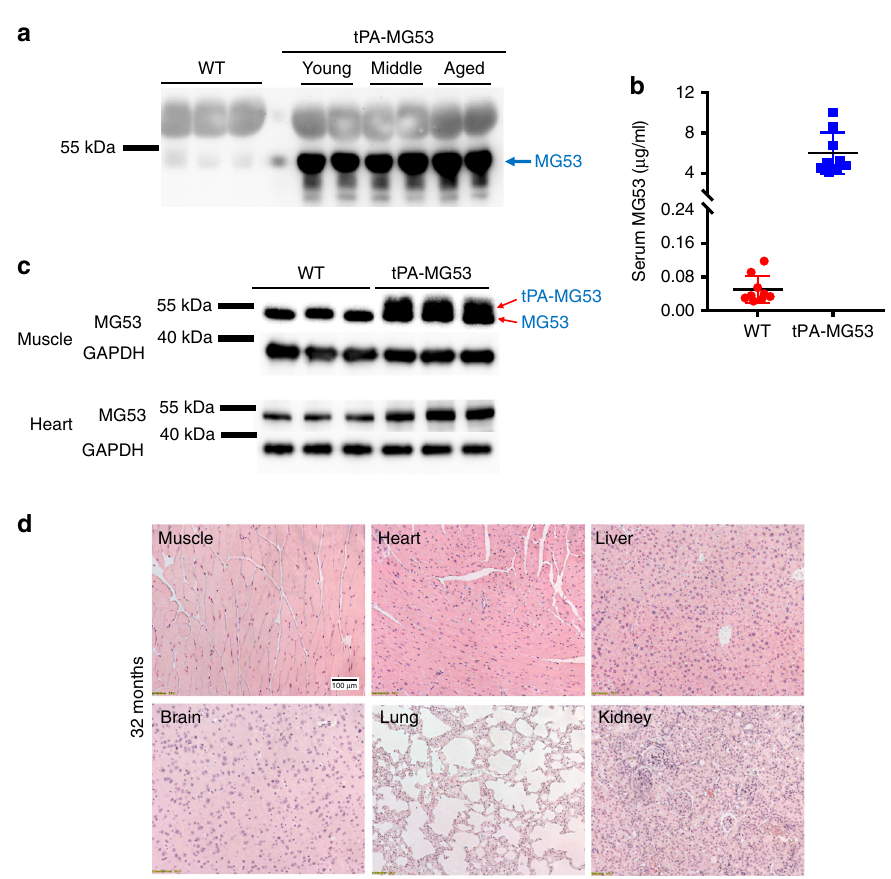
Fig. 1 Mouse model with sustained elevation of MG53 in the bloodstream. a 1 µ l sera derived from 3-month wild type (WT) and tPA-MG53 mice at 2 months (young), 12 months (middle) and 24 months (aged) were probed with anti-MG53 antibody. b Quanti fi cation of serum levels of MG53 in wild type and tPA-MG53 mice by western blot ( n = 10, wild type; n = 9 for tPA-MG53, P < 0.0001). c Skeletal muscle (2 µ g per lane) and heart (2 µ g per lane) derived from tPA-MG53 and WT littermate mice were blotted with anti-MG53 antibody. Red arrows indicate doublet of MG53 and tPA-MG53. d H&E staining of vital organs from 32-month-old tPA-MG53 mice show normal tissue morphology. The pictures are representative of two other tPA-MG53 mice at 32 months age. Error bar represents the standard deviation and P value was generated by t